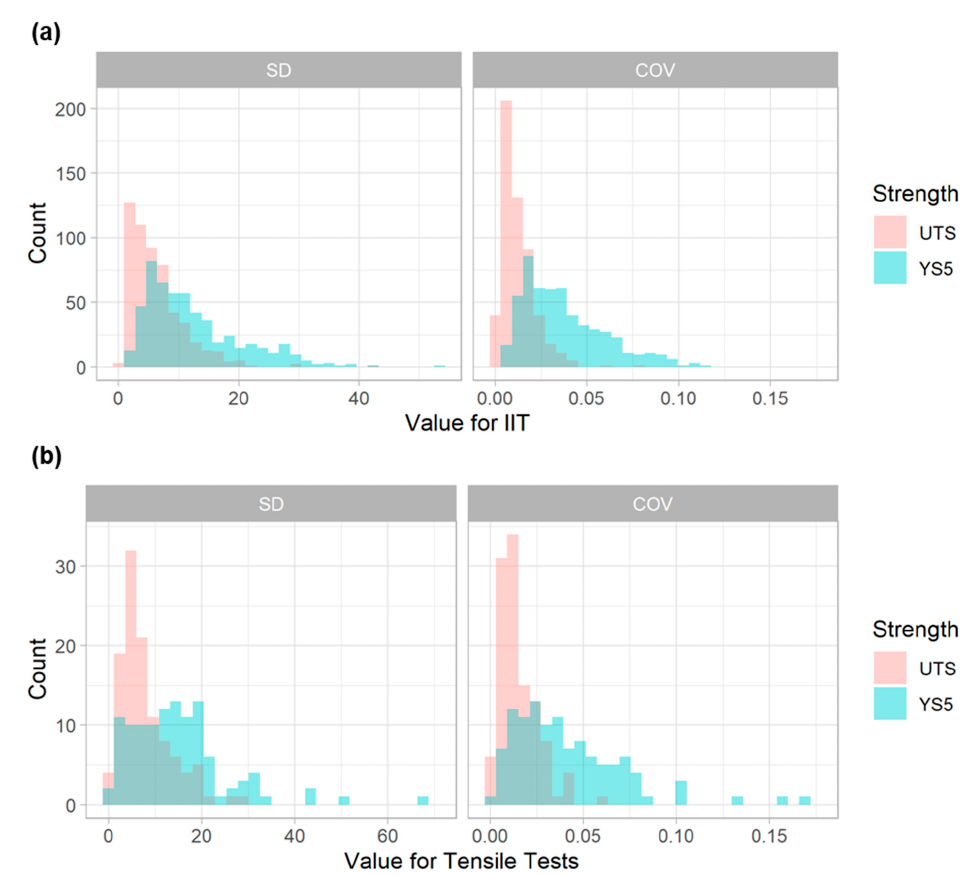
Materials 2022 , 15 , x FOR PEER REVIEW 10 of 24